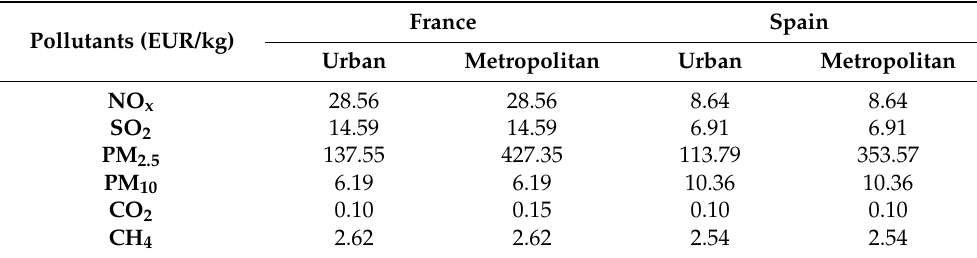
Table 3. The unitary cost of air pollutants for France and Spain in 2017.